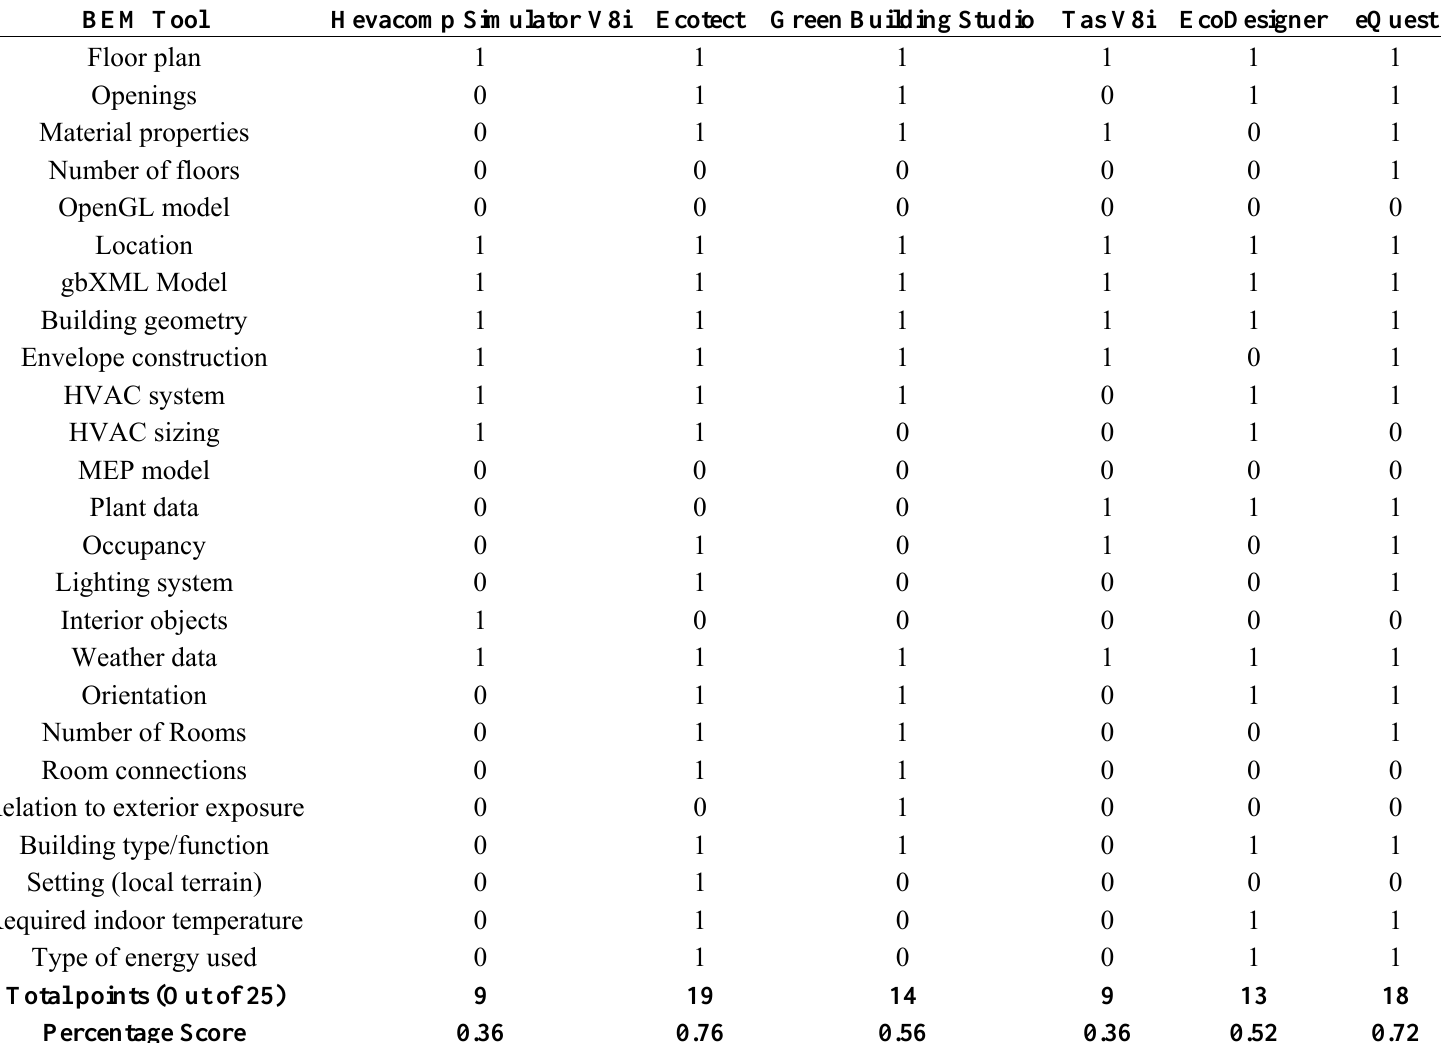
Table A4. Initial evaluation: available inputs criterion calculations for BEM tools (Part 2). BEM